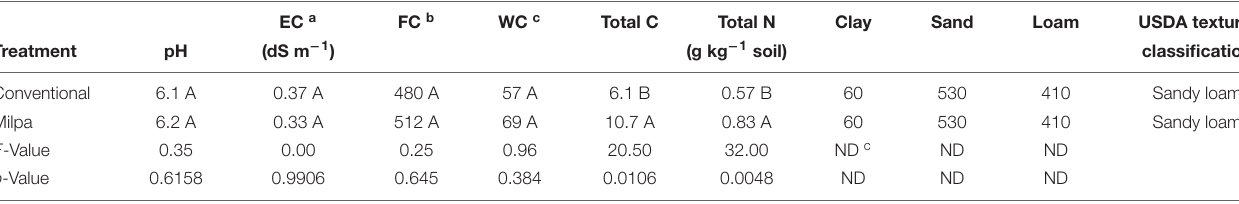
TABLE 1 | Characteristics of soil cultivated conventionally, i.e., conventional tillage, crop residues removal, chemical fertilizer and herbicide application and monoculture of maize ( Zea mays L.), or cultivated with an organic milpa system, i.e., zero tillage, retention of crop residues, organic fertilizer application, weed management and crop rotation of maize, pumpkin ( Cucurbita sp.) and beans ( Phaseolus vulgaris L.), for 3 years.